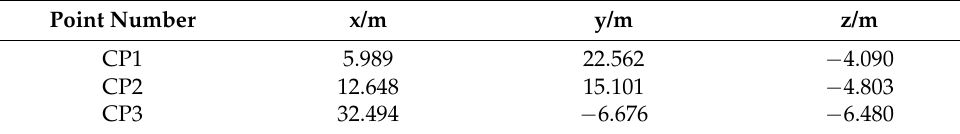
Table 7. Coordinates of three triangular pyramid vertices in phase 1.